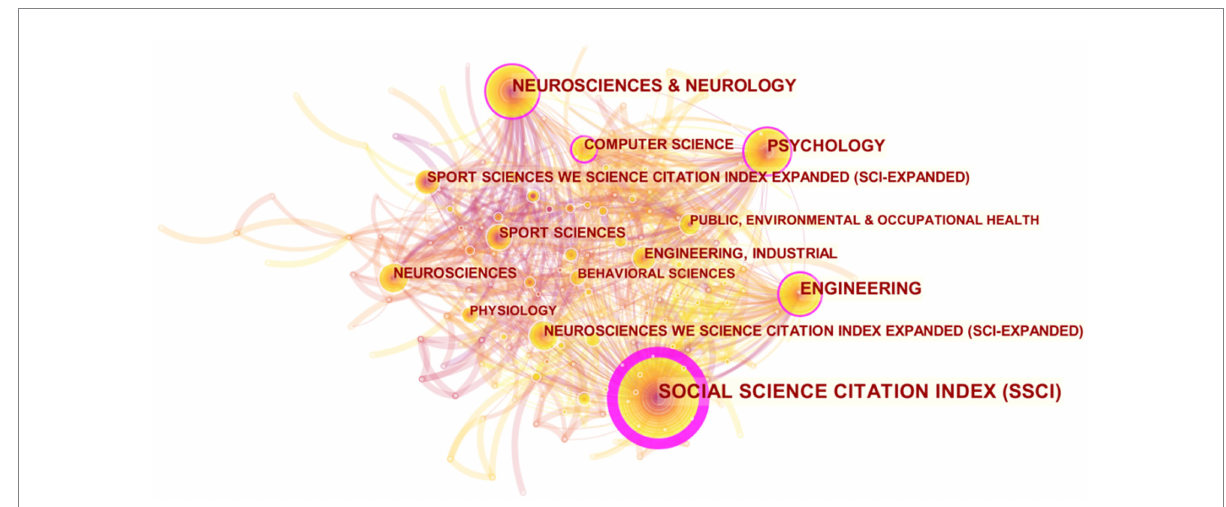
FIGURE 2 Main category regarding effects of mental fatigue on athletic